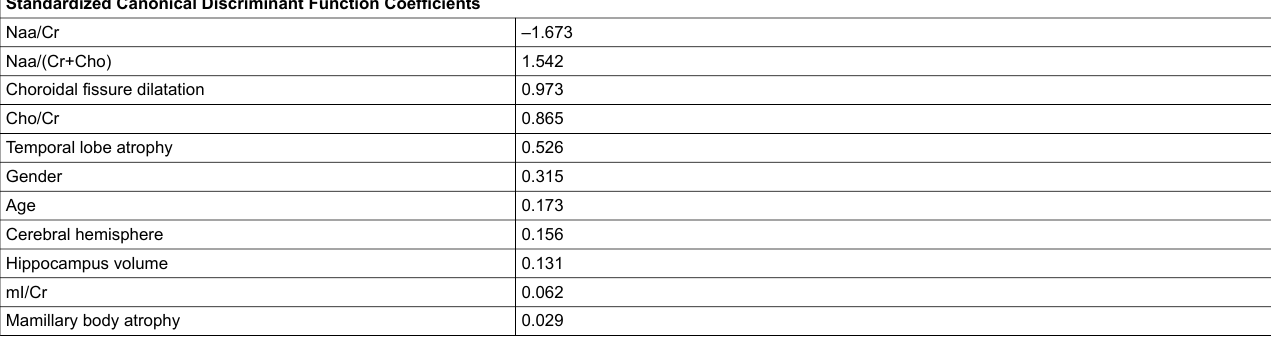
Table 3: Within-groups correlation matrix depicts the participant variables ordered by absolute size of correlation (Pearson coefficients) within function. The largest loadings for each discriminate function (pattern of secondary-findings followed by metabolite-indices scores) suggest a label of qualitative and quantitative MR values as the function that discriminates between with- and without-MTS. A value of 0.30 is considered as the cut-off between important and less important variables. Structure Matrix Choroidal fissure dilatation